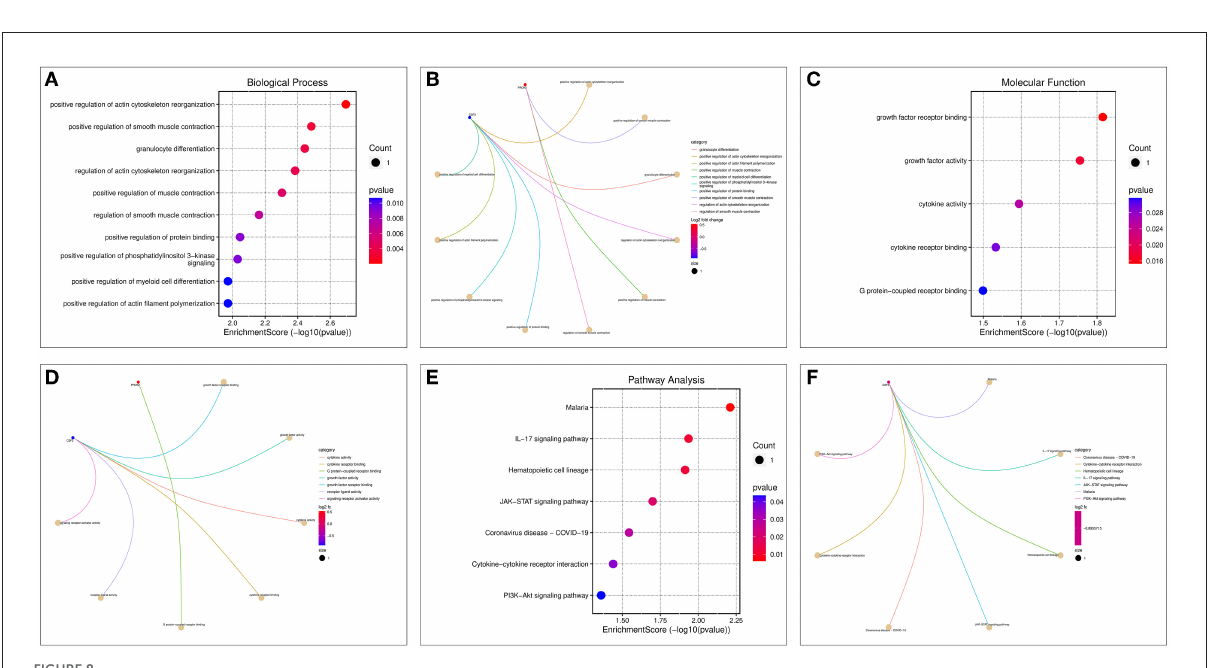
FIGURE8 GO and KEGG enrichment analysis of OP-inflammation-related genes. (A) BP enrichment bubble diagram; (B) BP enrichment arc diagram; (C) MF enrichment bubble diagram; (D) MF enrichment arc diagram; (E) KEGG enrichment bubble diagram; (F) KEGG enrichment arc diagram.